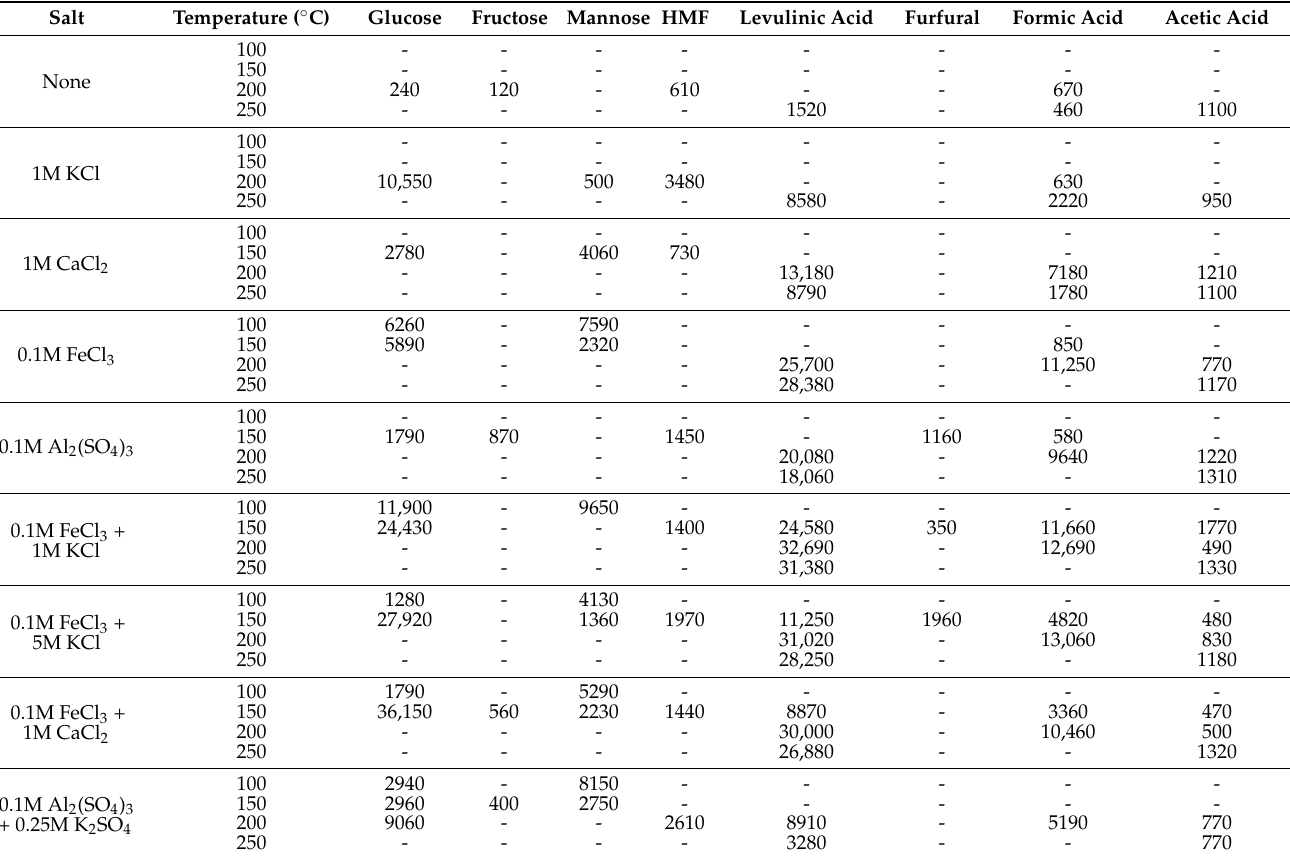
Table 1. Process water analysis by high-performance liquid chromatography (HPLC). Values reported as mg/L. Dashes denote the analyte was not